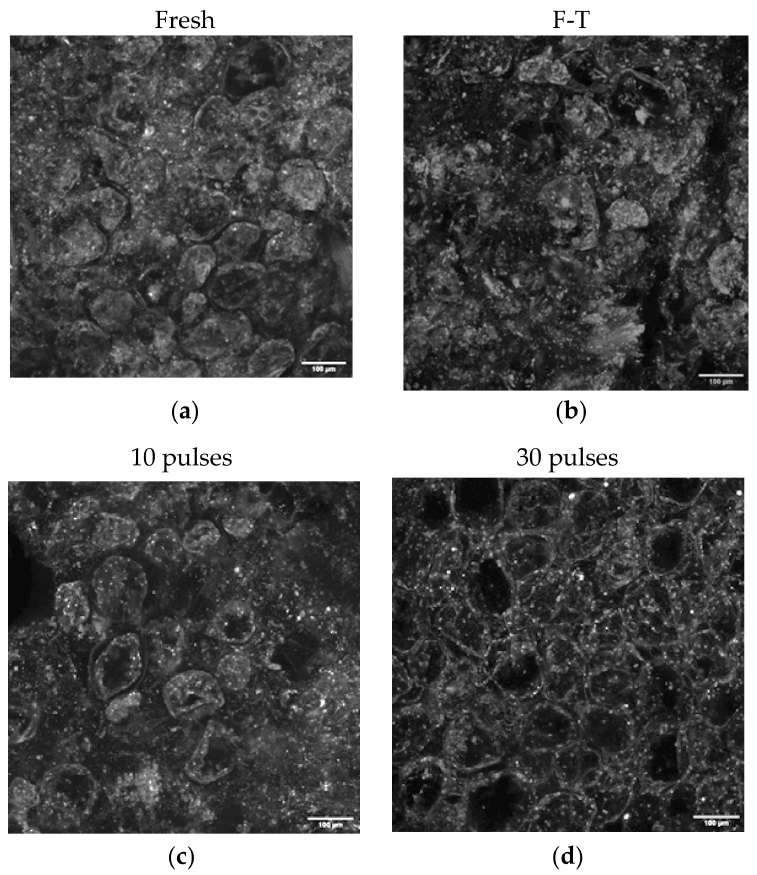
Figure 6. Microstructures of non-osmotic treated mango: fresh mango ( a ); after F-T ( b ); after 10 pulses ( c ) after 30 pulses ( d ). The white scale bar represents 100 µ